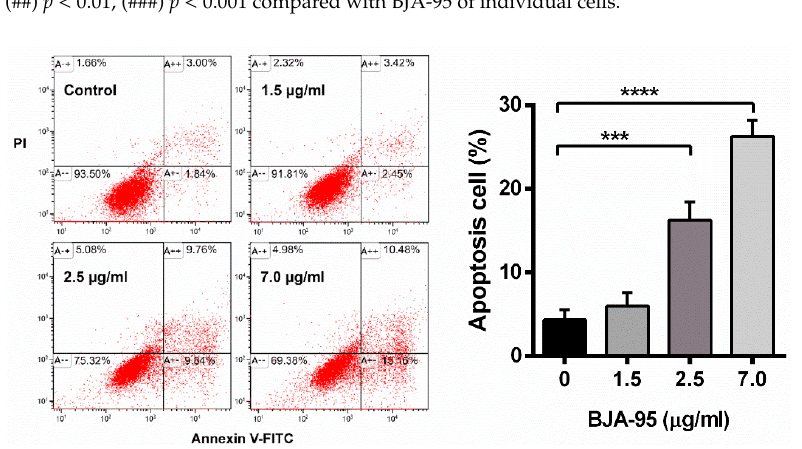
Figure 3. The effects of BJA on the expression of apoptotic-related proteins, caspase activities and mitochondrial transmembrane potential in CCA cells. KKU-213 cells were treated with indicated concentrations of BJA-95 for 24 h. ( A ) Expression levels of pro-apoptotic proteins (Bax, Puma and